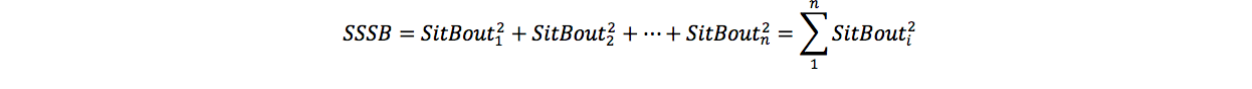
Figure 2. Equation summed squared sitting bouts.